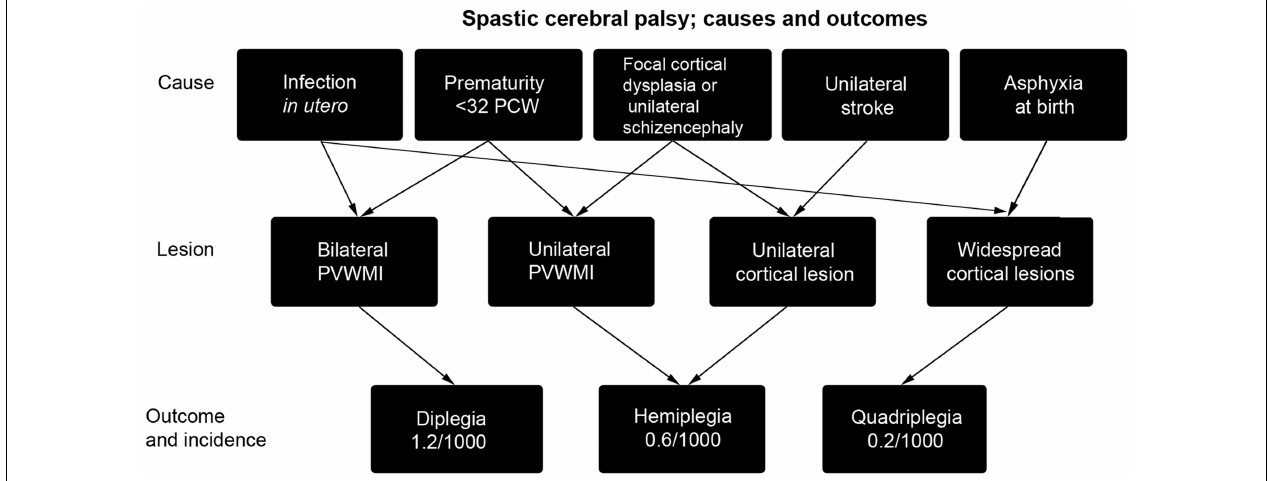
indicate, multiple causes may combine to produce cerebral palsy (4) and may also interact with subtle genetic variations in individuals that cause predisposition to stroke (6). PCW, post-conceptional weeks; PVWMI, periventricular white matter